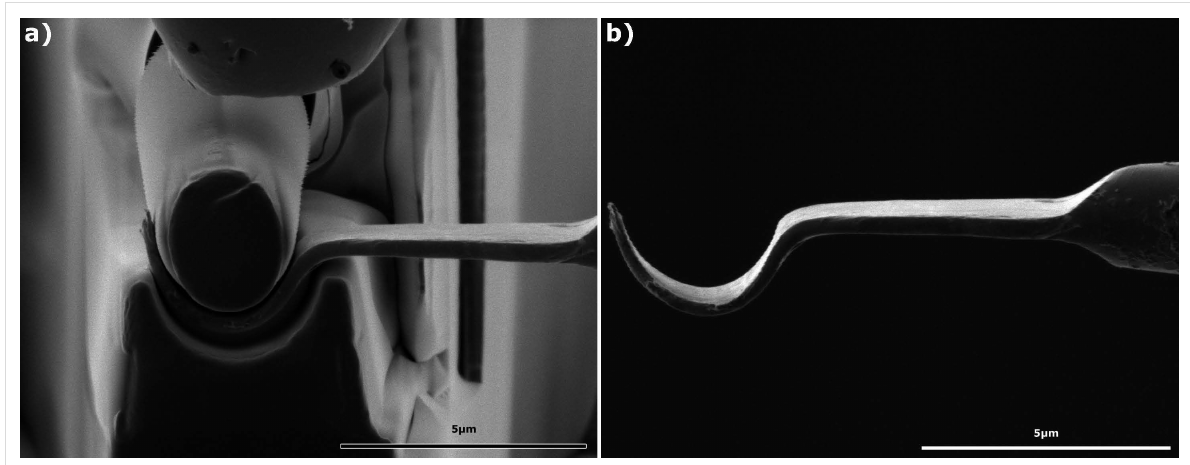
Figure 4: SEM images of the bending process. The flat bar is forged in the lower forging die and adapted its outer geometry. The inner shape is given by the cylindrical upper bending arm.